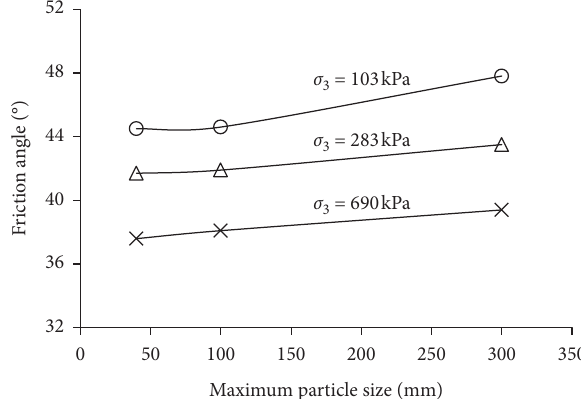
Figure 6: Variation of friction angle with maximum particle size of parallel modeled samples with different confining pressures (data taken from